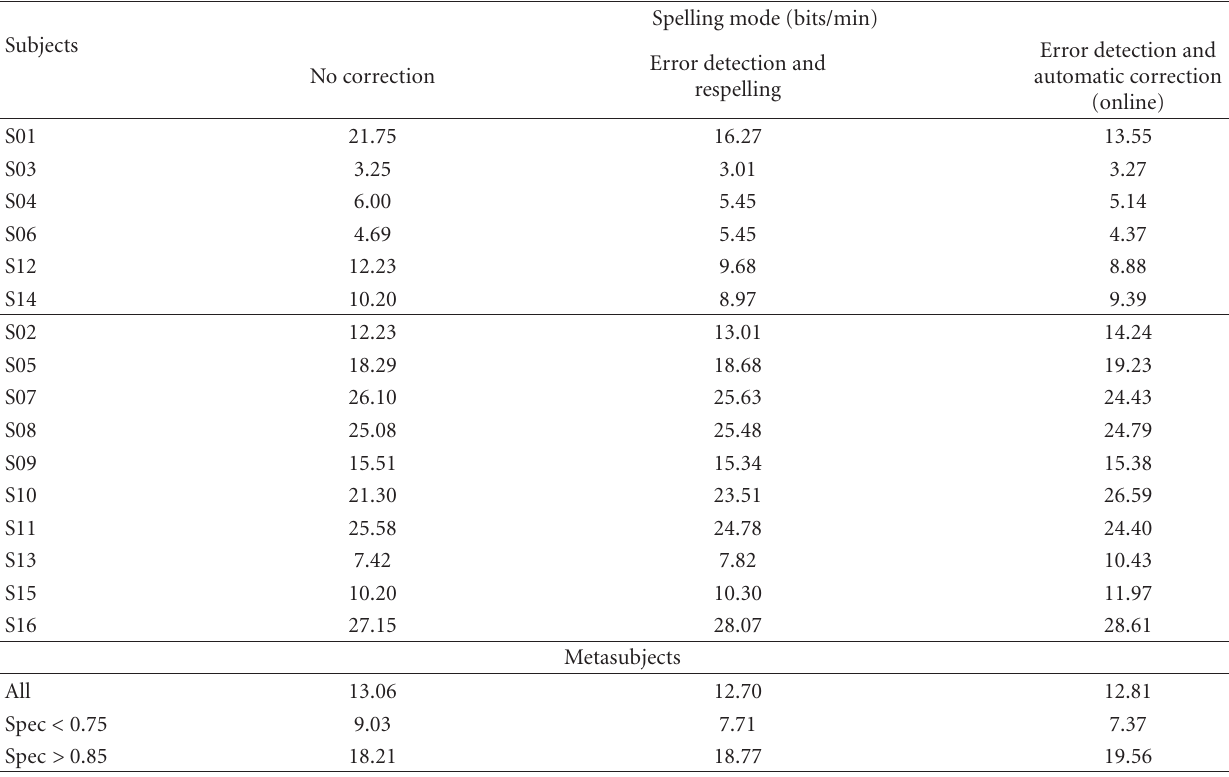
Table 2: Bits per minute for the three compared spelling modes: no correction at all, automatic detection and predicted correction due to respelling, and automatic correction (online results).